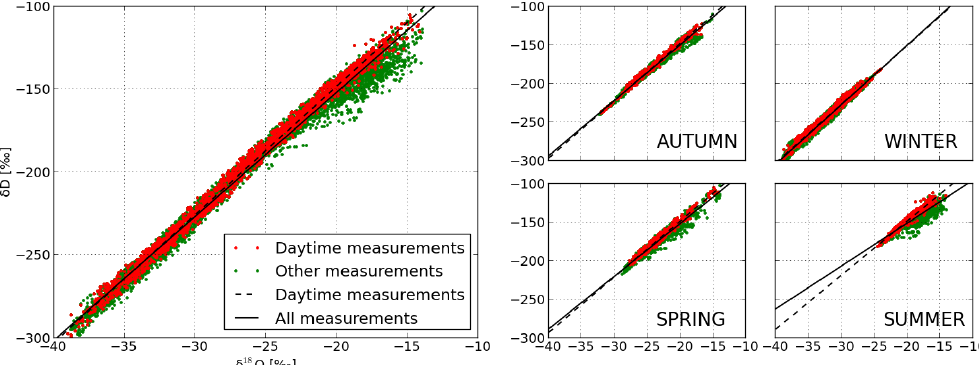
Figure 7. δ D vs. δ 18 O. Left panel: all measurements, right panels: seasonal measurements, red dots: daytime measurements (from 12:00 to 21:00LT), green dots: all other measurements, dashed line: linear fit through daytime measurements of the graph, solid line: linear fit through all measurements of the graph. See Table 2 for calculations of determination coefficients and slopes.